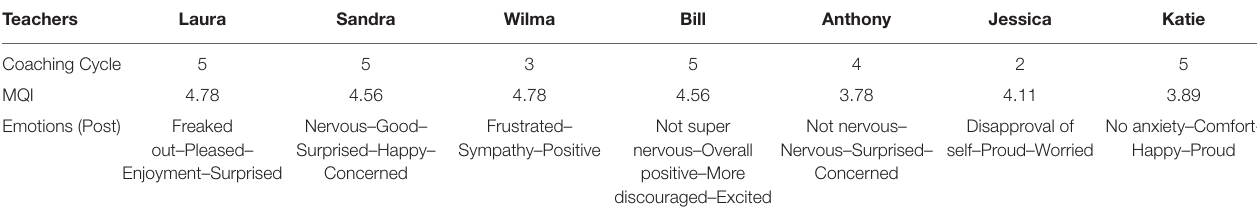
TABLE 5 | Comparison between teachers’ instructional quality and their